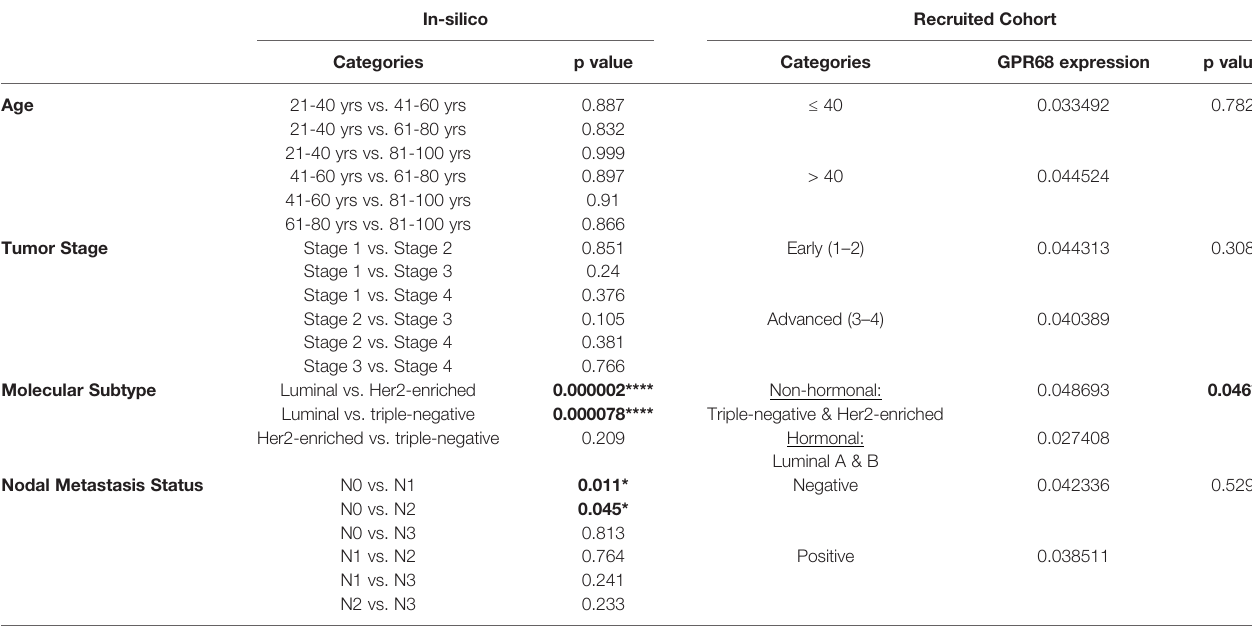
TABLE 2 | Association between GPR68 expression and the clinicopathological parameters of breast cancer patients, using data from the in-silico and the recruited cohort in the study.